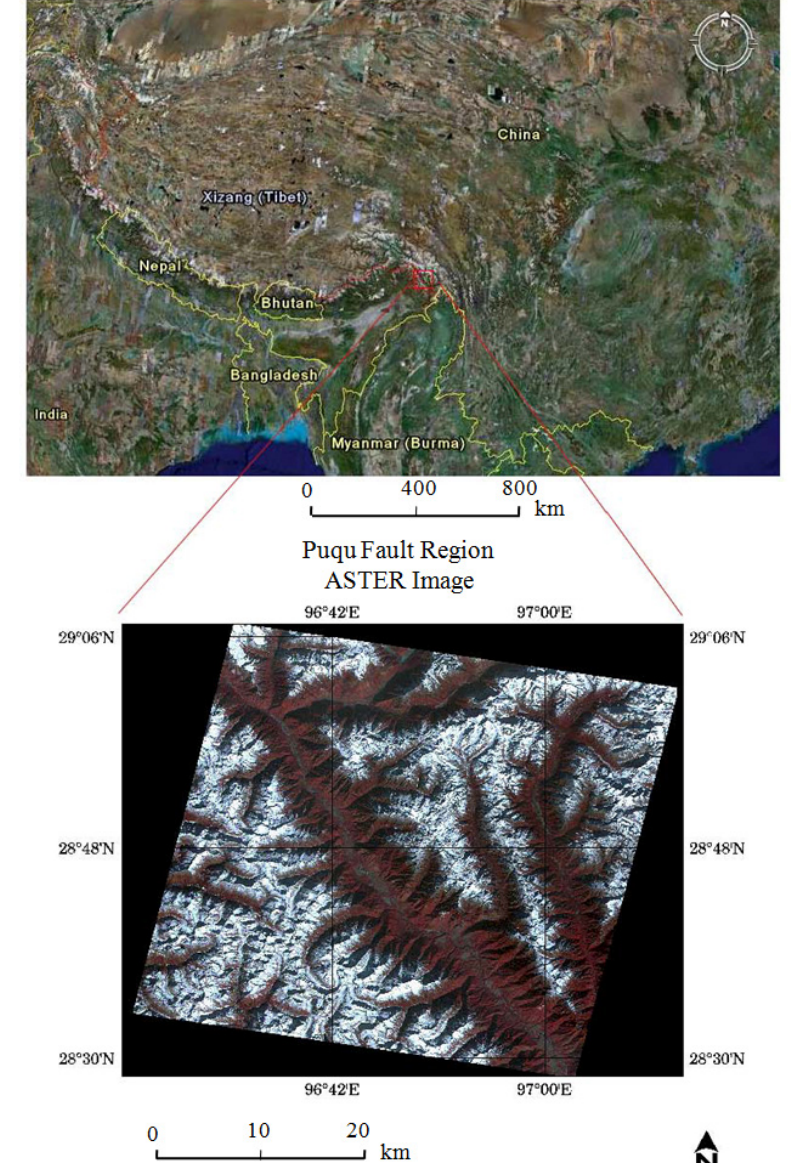
Figure 1. Location of the Puqu Fault Region. The red box shown in the upper map (information available in Google Earth) shows that the study area is located on the boundary of China, India and Myanmar. The lower map is from the ASTER image with the 3-2-1 (red-green-blue) color combination, showing the main coverage of the Puqu Fault and its surrounding area. The ASTER Level 1A data (raw digital numbers quantized as 8-bit unsigned integers) was acquired and the date of image acquisition was 3 January